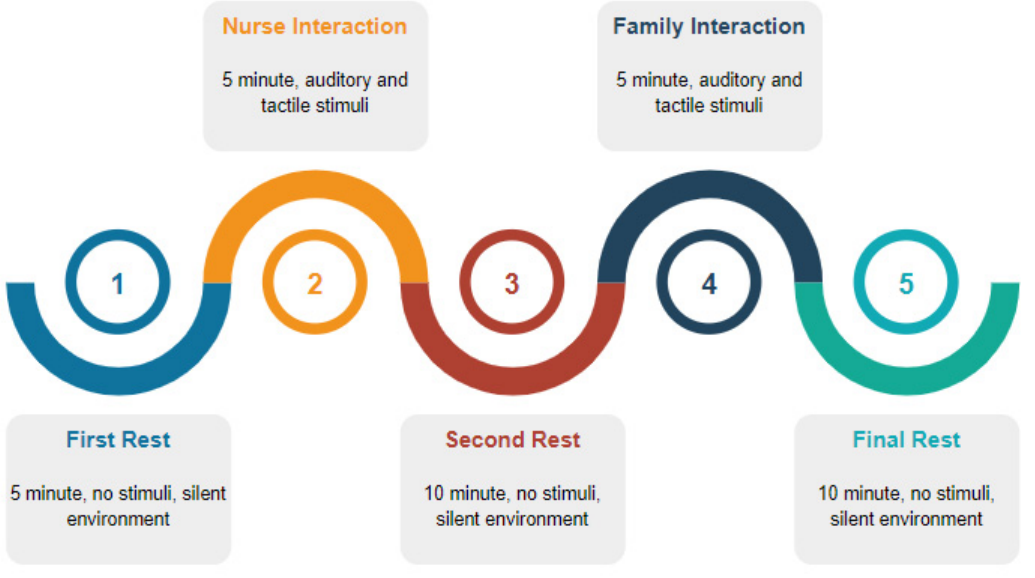
Figure 3. Proposed recording stages.